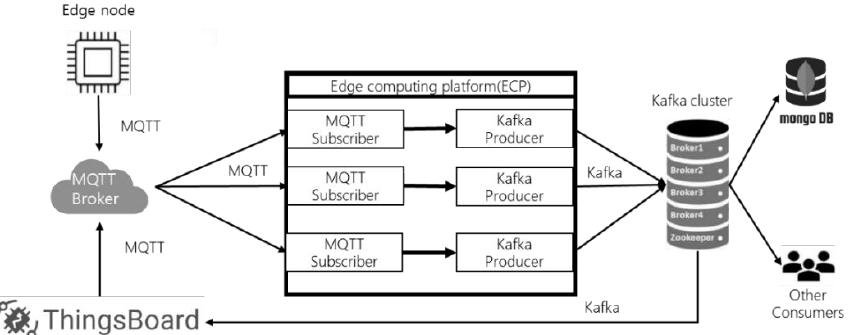
Figure 1. Overall s ystem architecture. Figure 1. Overall system architecture.